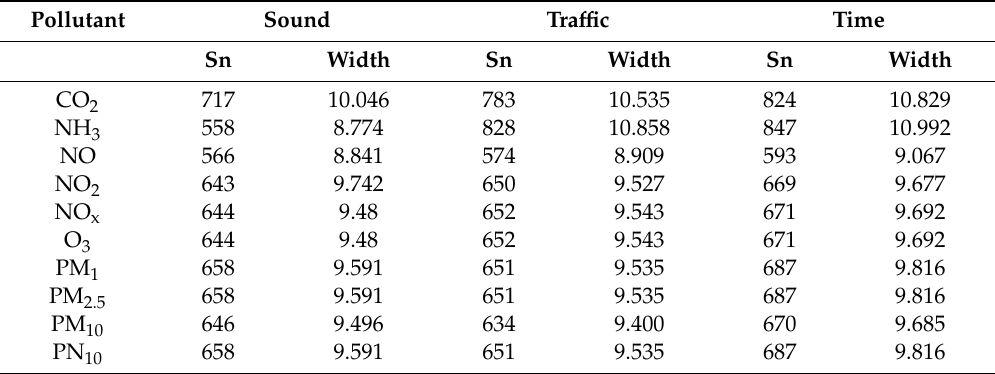
Table 2. Calculated SOM grid sizes (SOM gs ) and sample sizes (Sn) for each pollutant.